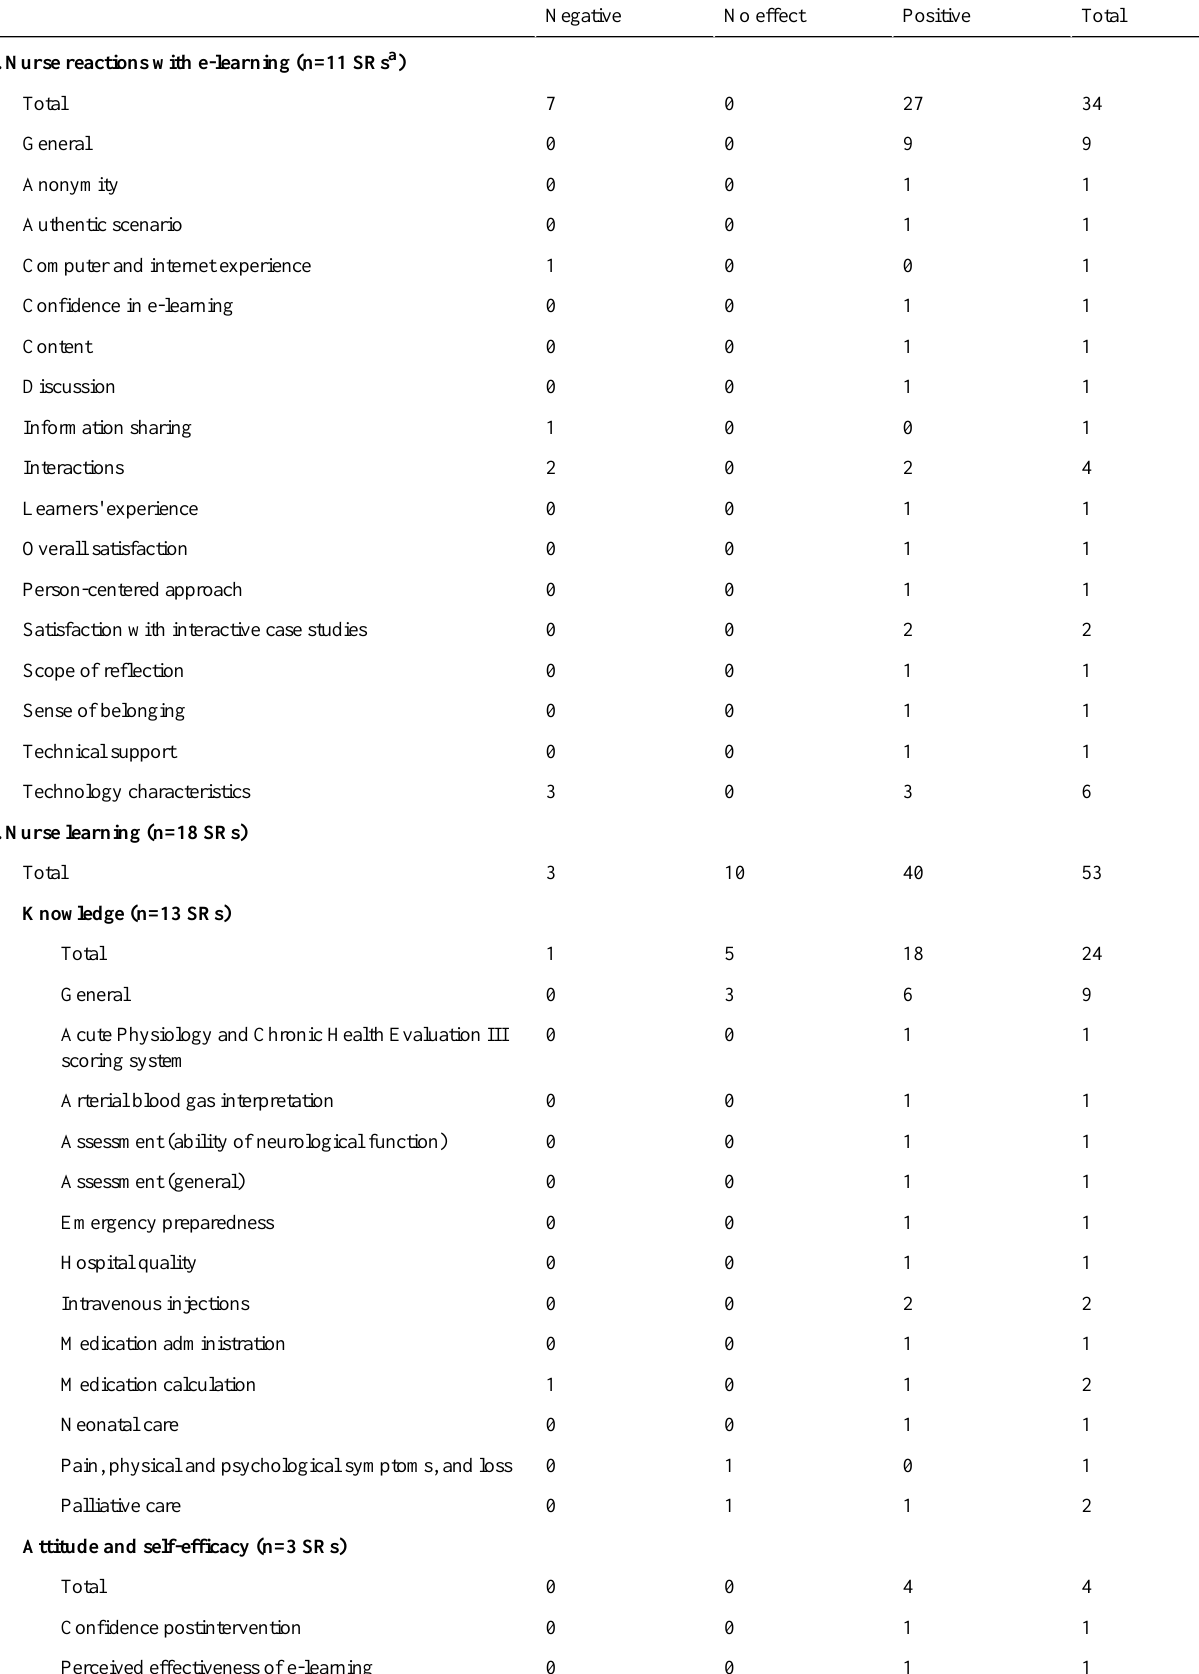
Table 3. Frequency and direction of